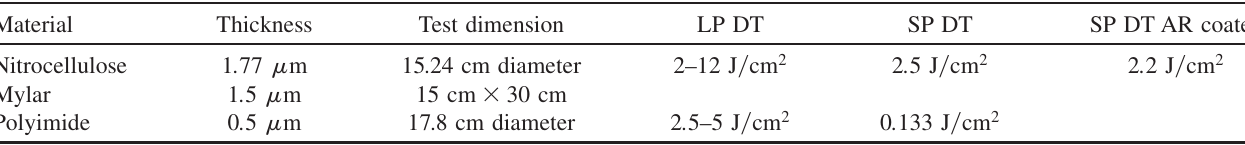
TABLE I. List of materials that were studied as well as their long pulse damage threshold (LP DT), short pulse damage threshold (SP DT) and AR coated SP